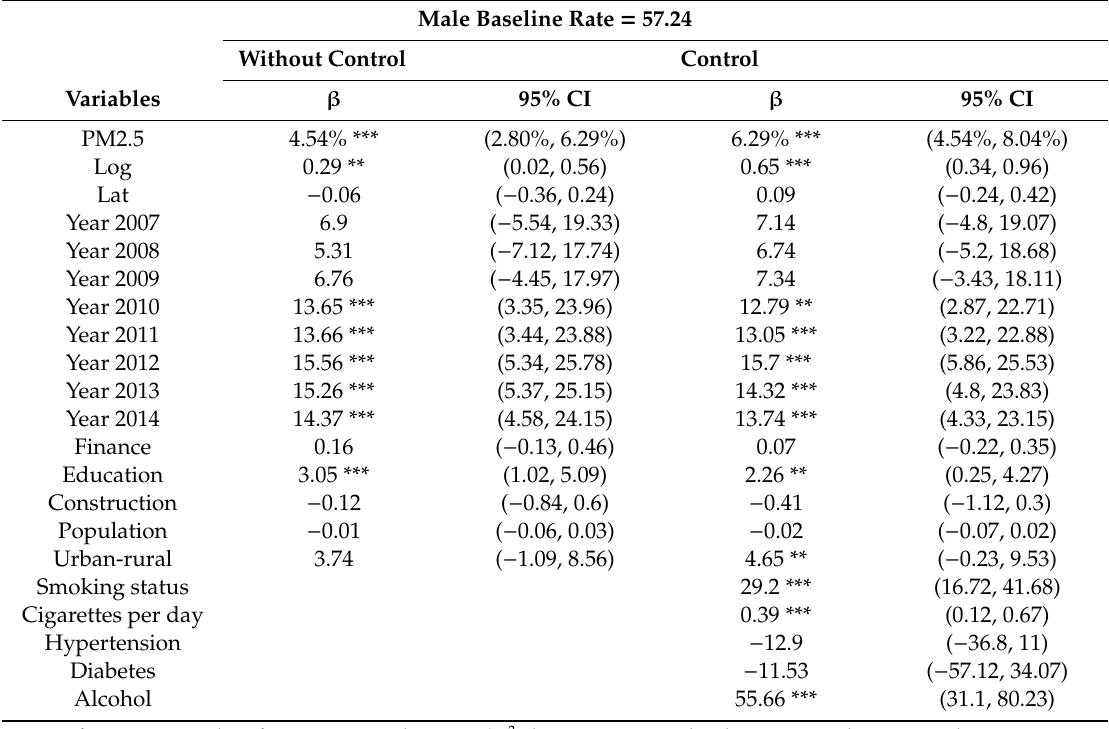
Table 4. Sensitivity analysis of PM2.5 e ff ect adjusted by health and behaviour covariates for males. Male Baseline Rate = 57.24